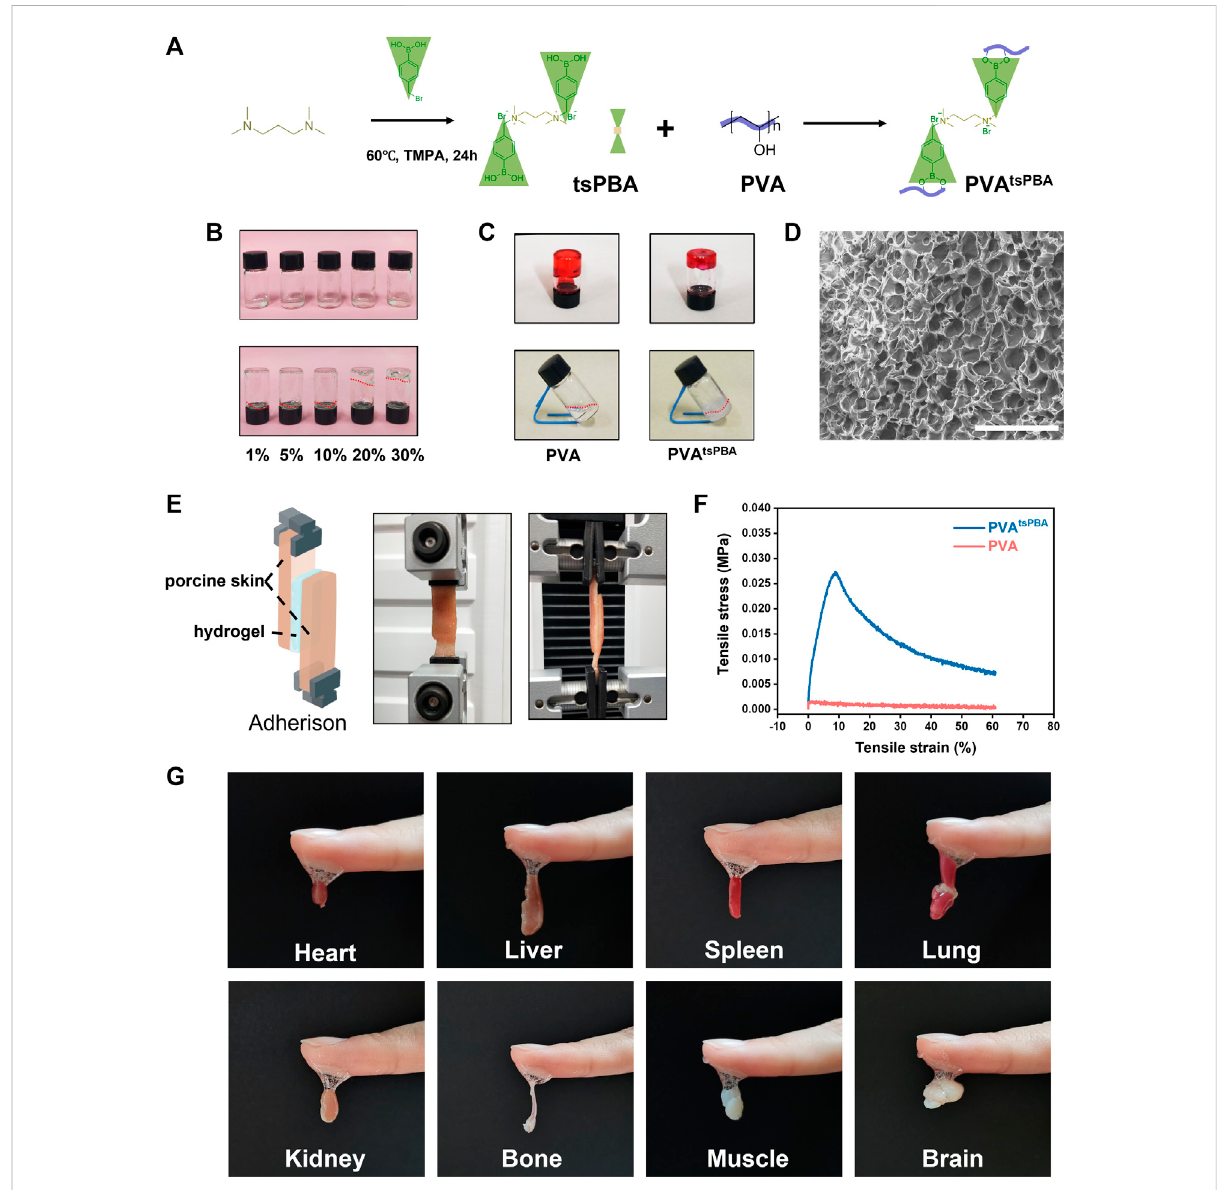
FIGURE 1 Characterization of hydrogel formed by PVA. (A) Simpli fi ed chemical structures of tsPBA and crosslinking with PVA. (B) Different physical states ofthe10%tsPBAhydrogelwith1%,5%,10%,20%,and30%PVA,respectively.Preparedsolutions(above).Physicalstatechangesafterseveralminutes (below). (C) 30%PVAwith10%tsPBAshowsabettersol – geltransitionthanPVAalone. (D) Scanningelectronmicroscopy(SEM)ofthisPVA tsPBA (scale bars:100 μ m). (E) RepresentativeimagesofPVAandPVA tsPBA